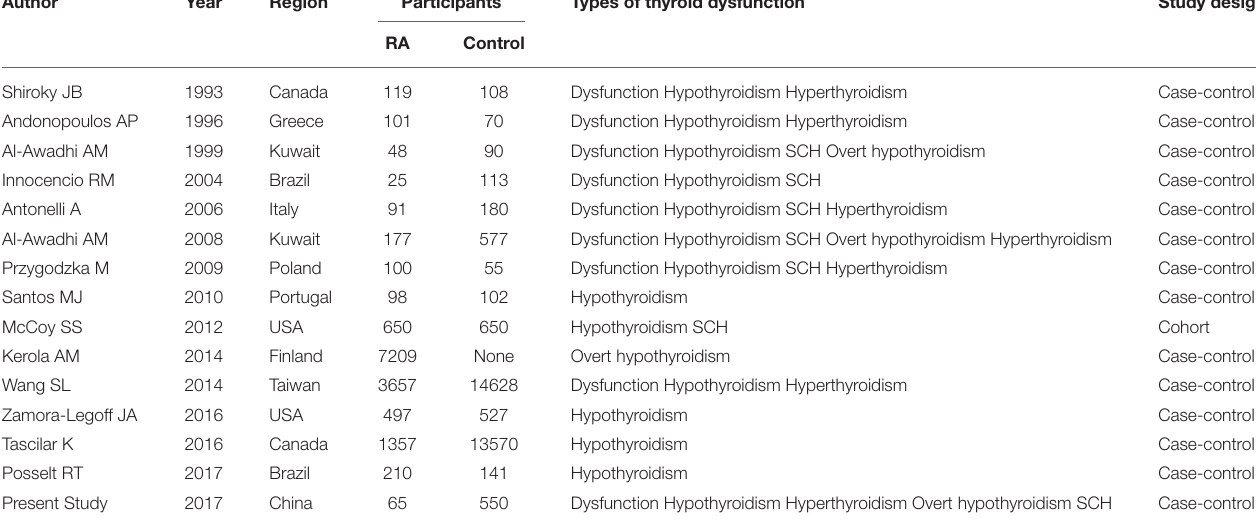
TABLE 4 | Characteristics of 15 studies included in the